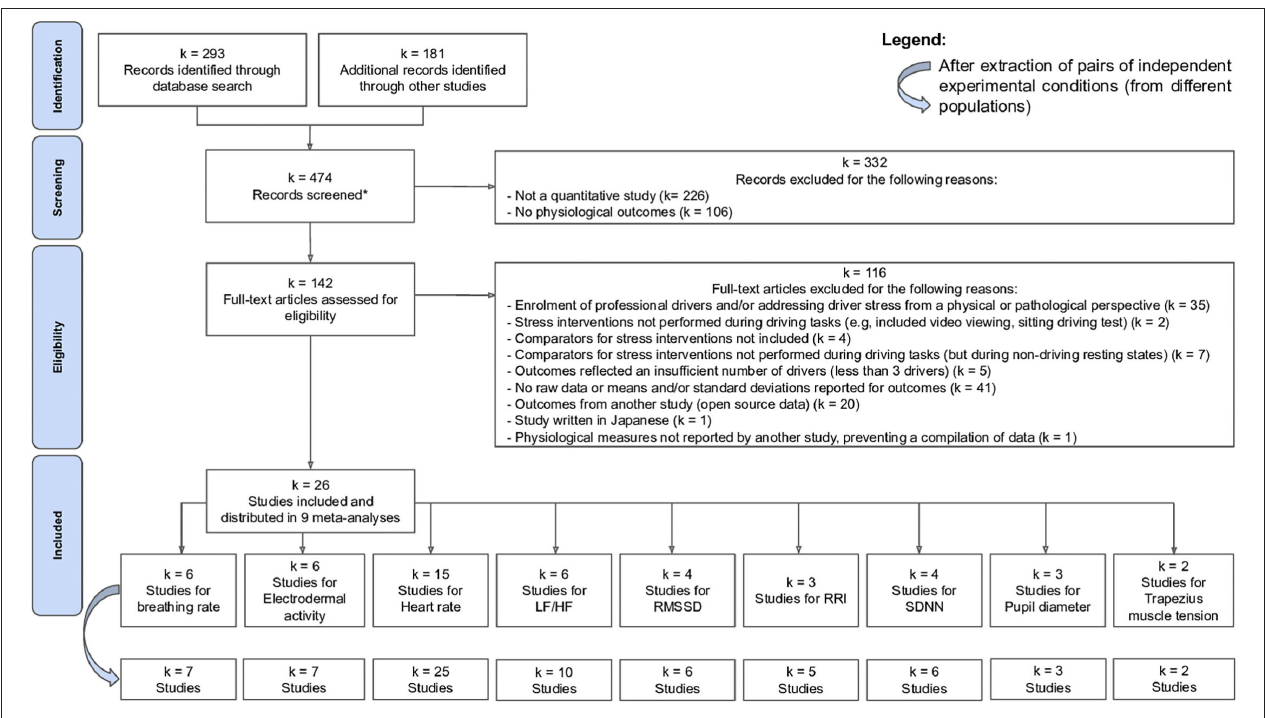
FIGURE 1 | PRISMA flowchart describing the methodology and search results. LF/HF, ratio of low frequency to high frequency; RMSSD, root mean square of successive differences among successive R-R normal intervals; RRI, means of R-R intervals; SDNN, standard deviation of normal R-R